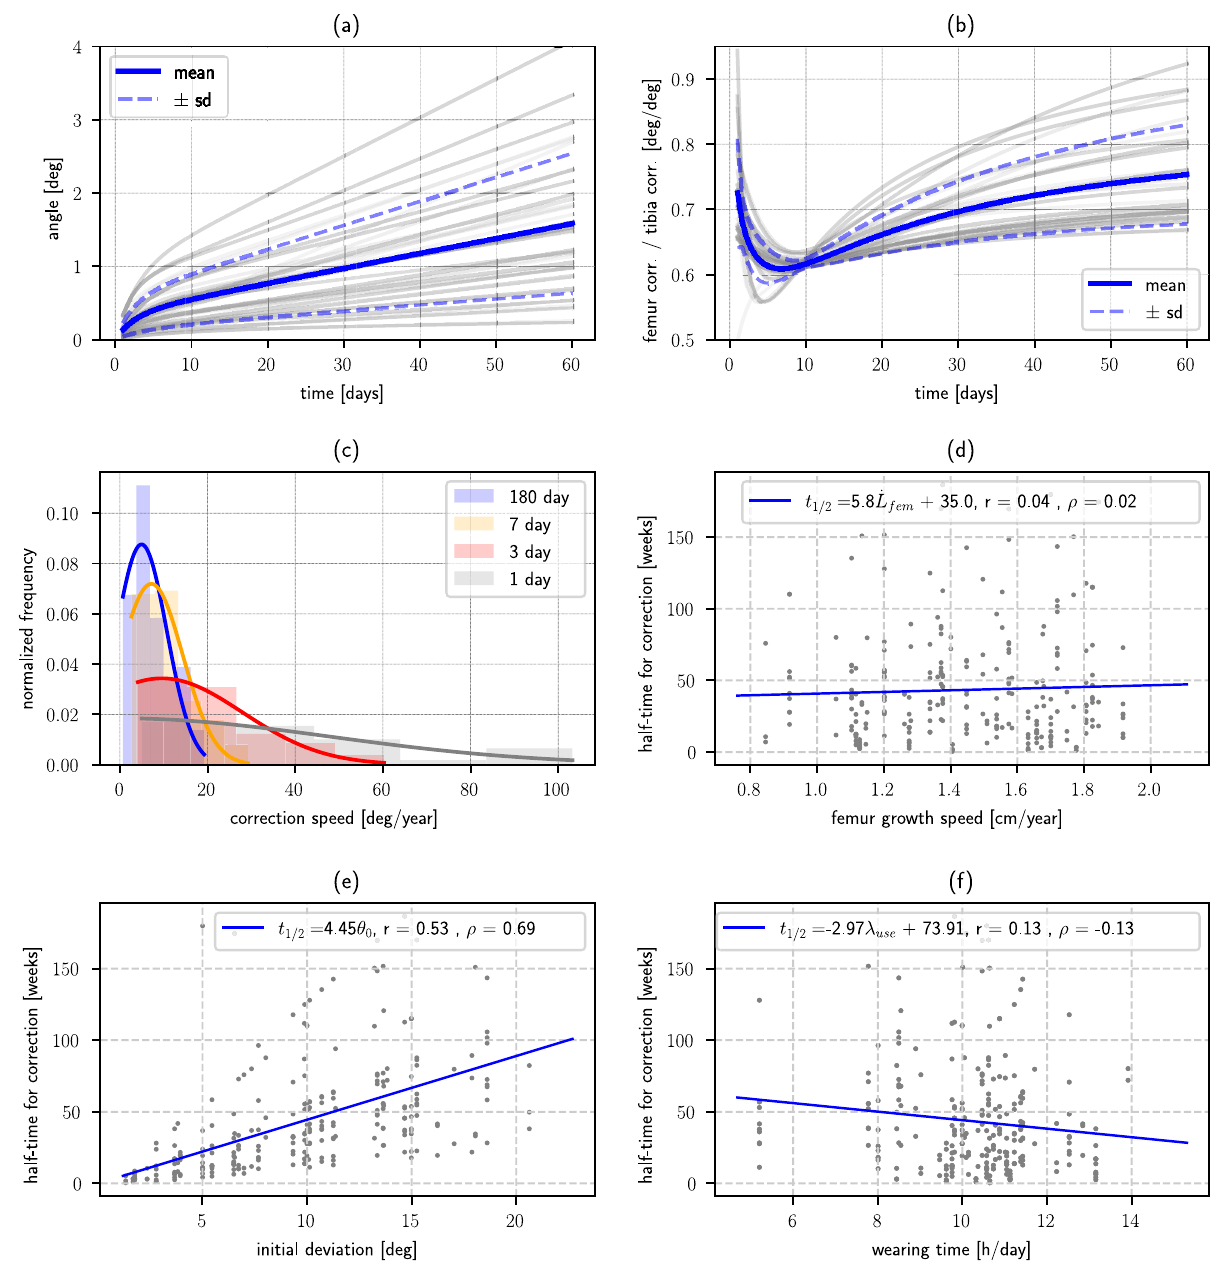
Figure 5. Growth evolution quantifiers in a set of 200 stochastic runs, for an orthotic applying a constant correcting load. ( a ) Change in the knee deviation angle evolution. ( b ) Femur versus tibia correction ratio evolution. ( c ) Correcting speed pdf. as a function of time. ( d ) Dependence of correction time with growth speed. ( e ) Dependence of correction time with initial deviation. ( f ) Dependence of time for correction with the time the patient uses the